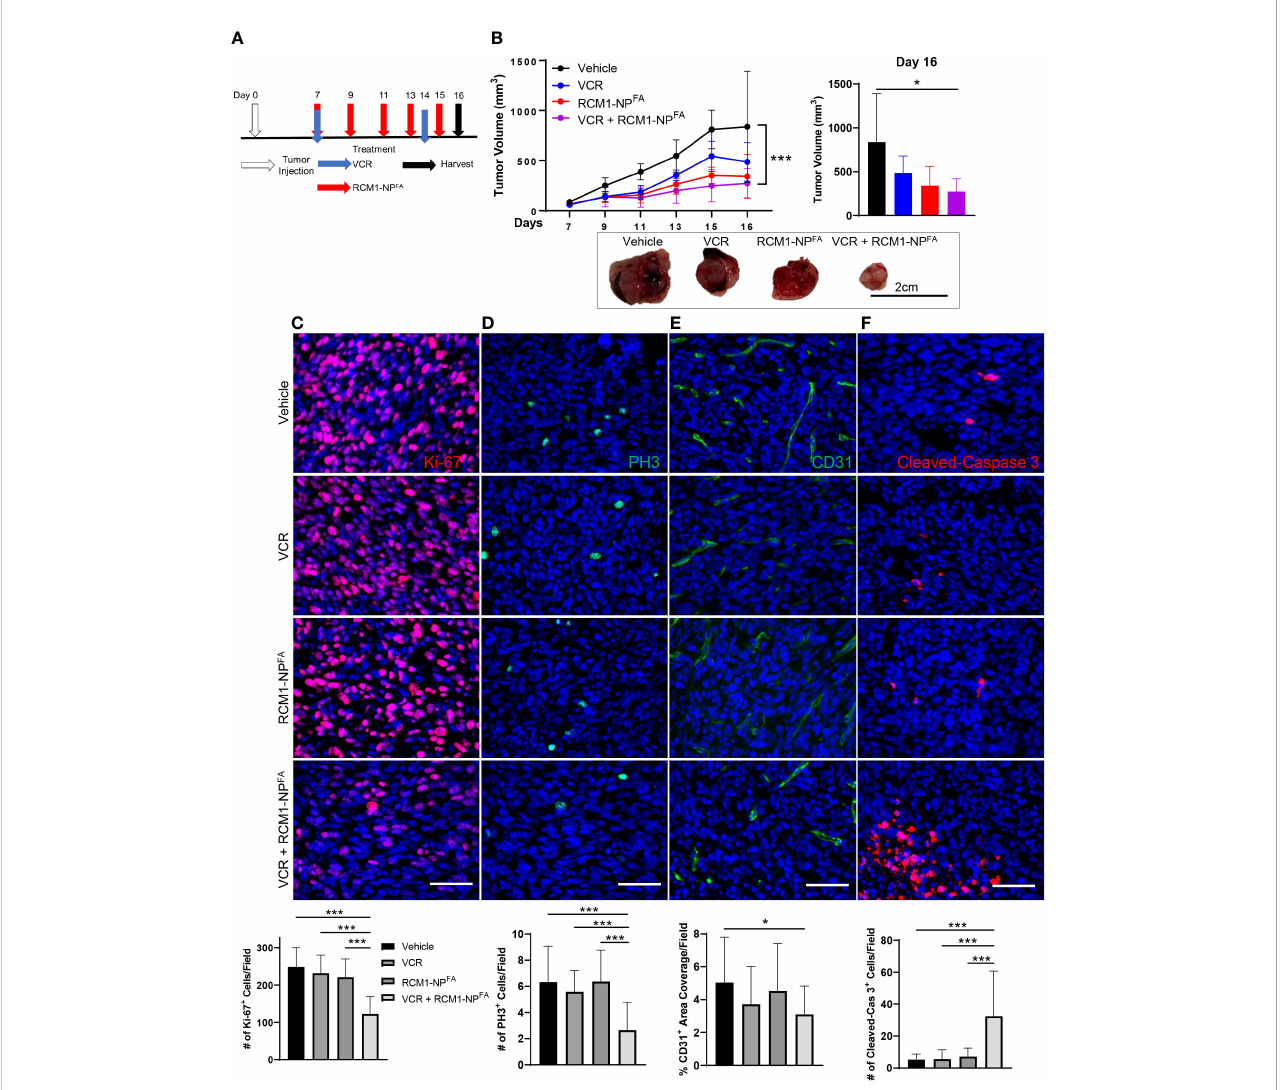
FIGURE 4 Combination treatment with low dose of VCR and RCM1-NP FA is more ef fi cient than single agents in reducing rhabdomyosarcoma tumor burden in mice. (A) , Experimental treatment strategy using low doses of VCR and RCM1-NP FA as single agents or in combination. Mouse rhabdomyosarcoma Rd76-9 cells were subcutaneously injected. Tumor-bearing mice were treated with IC 50 dose of VCR (0.25mg/kg), IC 50 dose of RCM1-NP FA (8µg) as single agents or in combination starting at day 7 after tumor cell inoculation. (B) , Combination therapy reduced tumor volume compared to vehicle (saline + empty-NP FA ) control. Tumor volume measurements are shown at different time points (top left) and the end of the study (day 16, top right). Representative tumors per group are shown (bottom). (C) , Combination therapy is more ef fi cient in reducing tumor cell proliferation (Ki-67, red) and mitosis ( D , PH3, green) compared to single agents alone and vehicle control. (E) , Combination therapy reduces tumor-associated angiogenesis (CD31, green) compared to vehicle control. (F) , Combination therapy induces apoptosis (Cleaved-Caspase 3, red) compared to single agents and vehicle control. 5 random fi elds per sample were used to quantify the number of Ki-67 + , PH3 + , CD31 + and Cleaved-Caspase 3 + cells per group. Values are shown as mean ± SD. n=5-6, * P <0.05; *** P <0.001. Scale